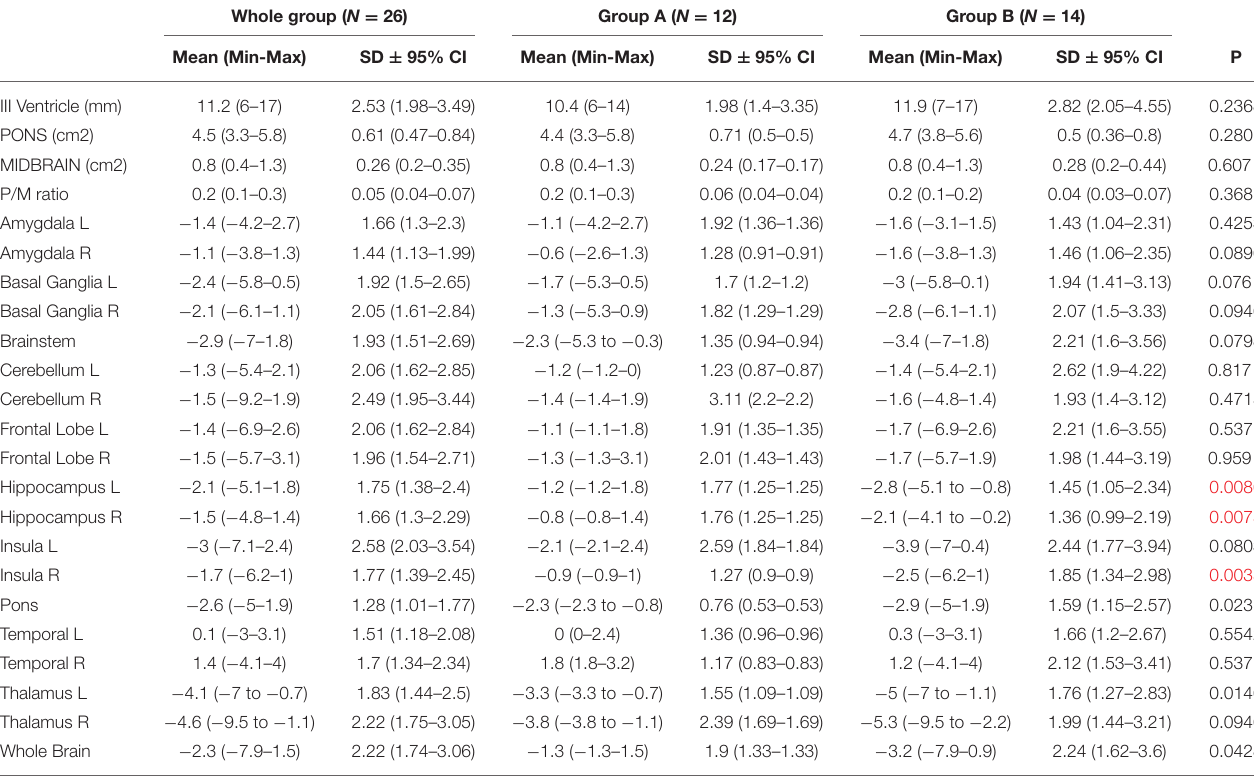
TABLE 1 | Basic statistics with subgroup